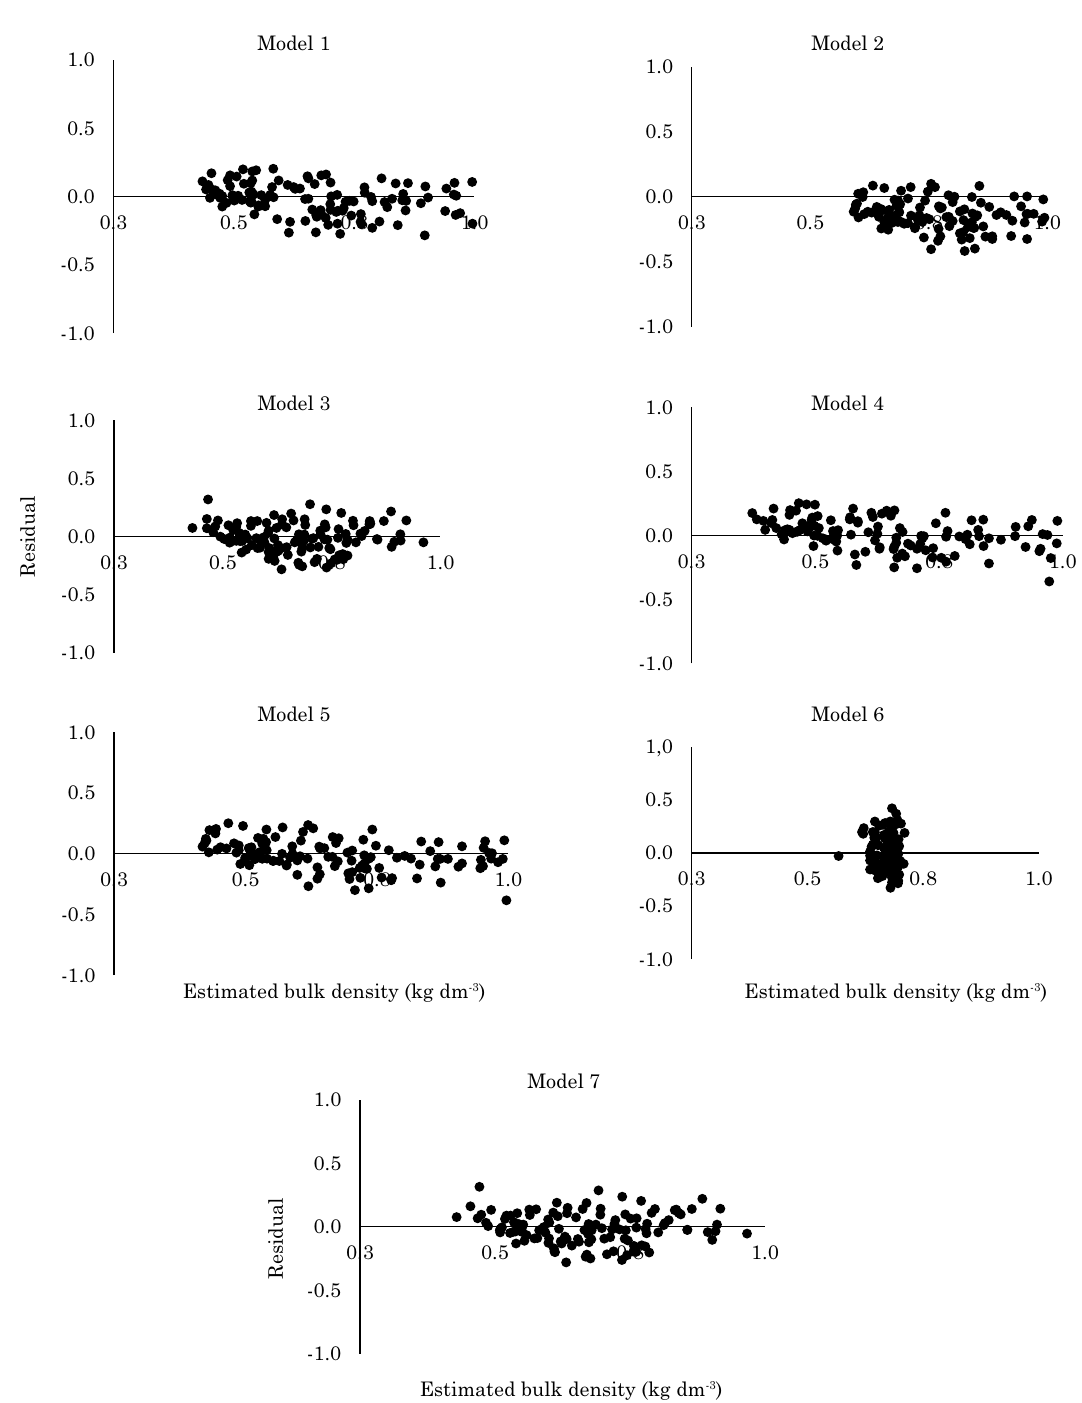
Figure 3. Regression residuals versus estimated values for soil